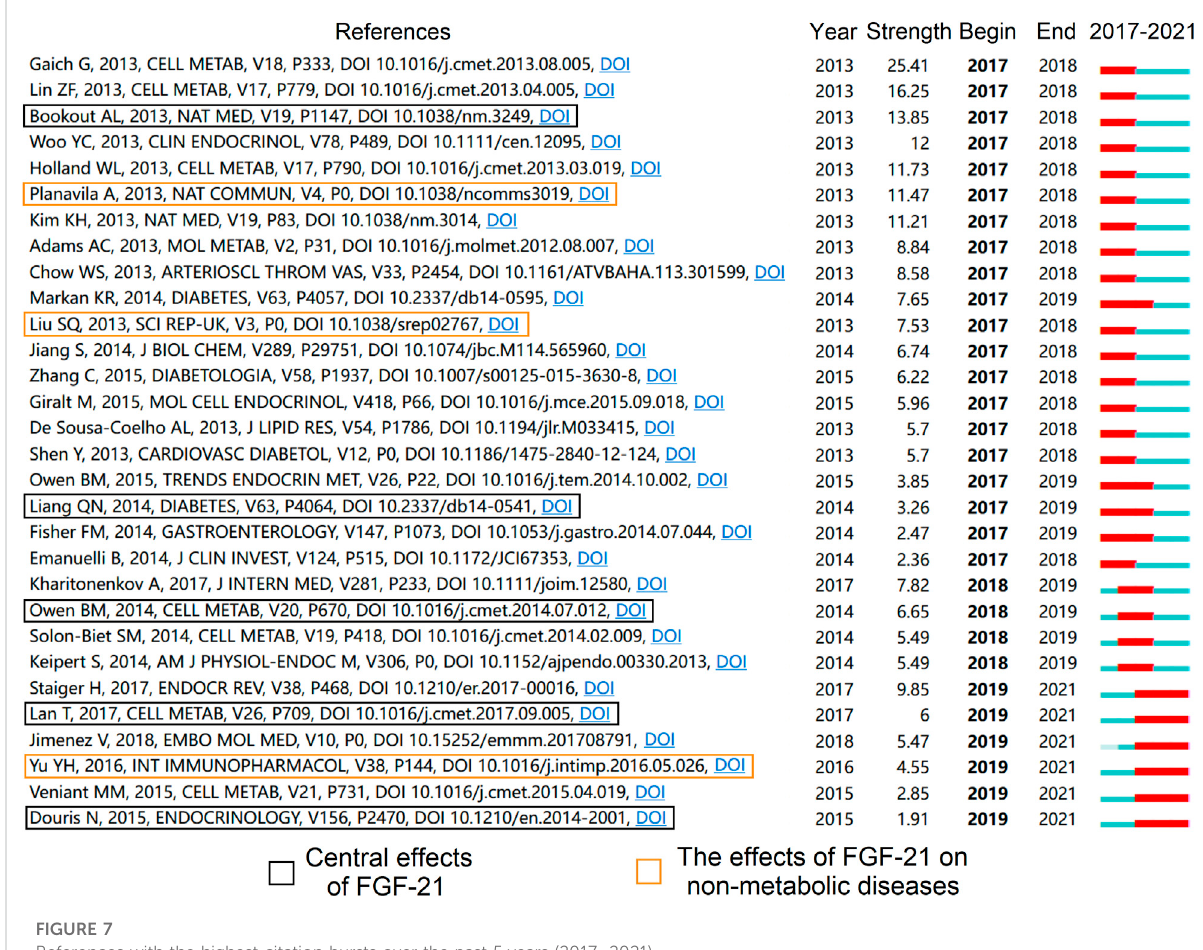
FIGURE 7 References with the highest citation bursts over the past 5 years (2017 –